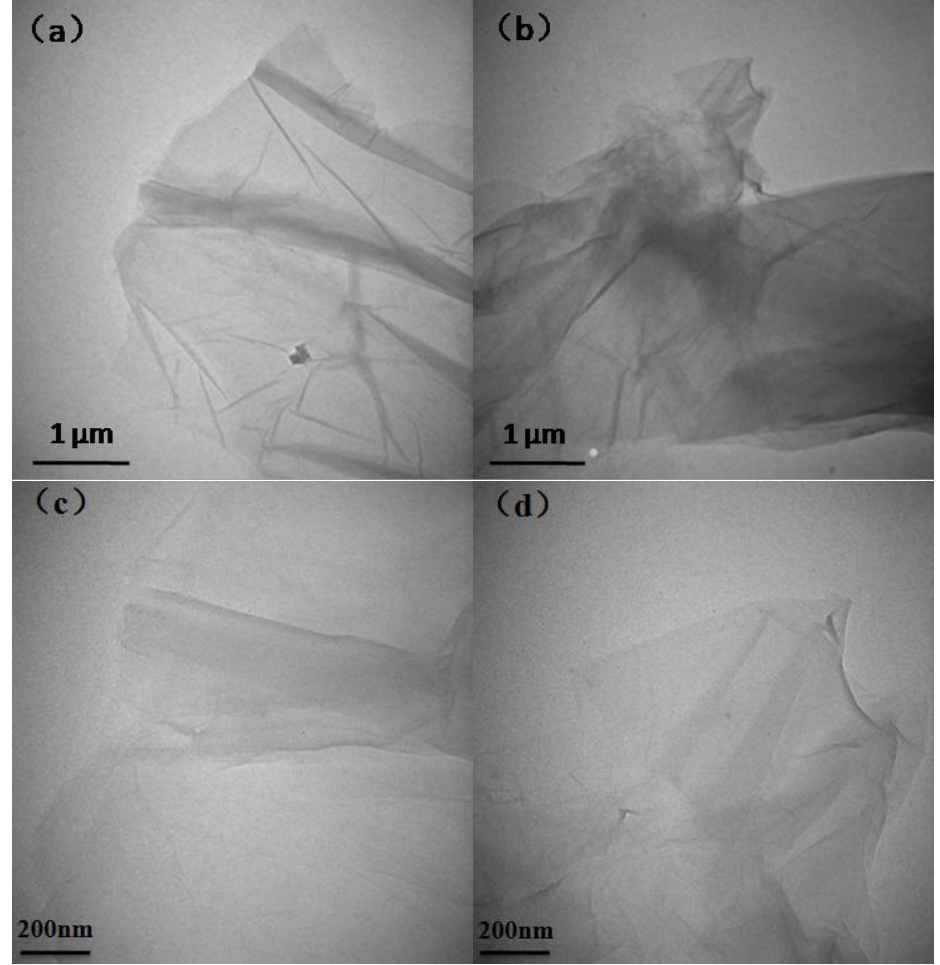
Figure 6. TEM microphotographs of GO ( a , c ) and SGO ( b , d ).